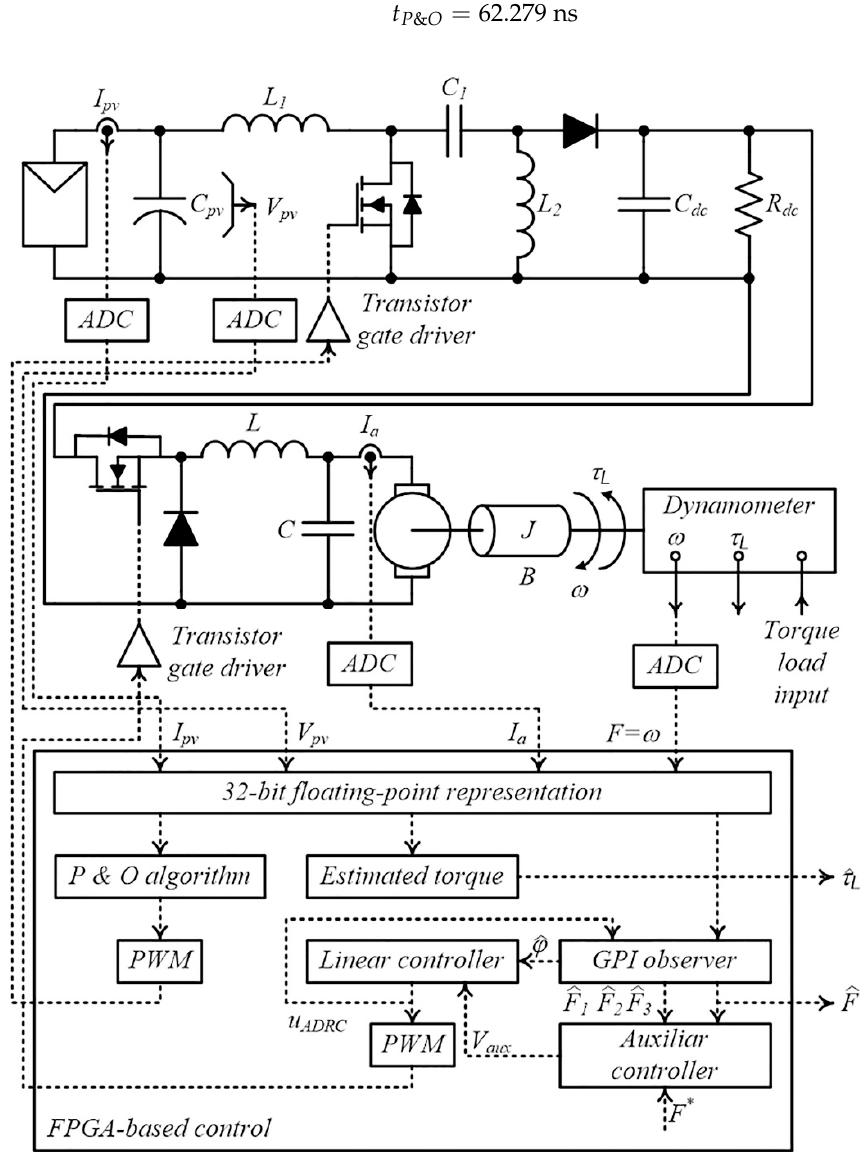
Figure 8. Block diagram of the proposed